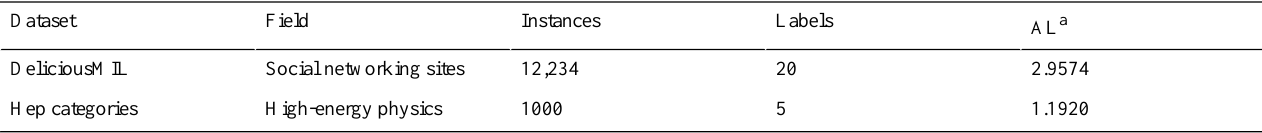
Table 2. Description of public